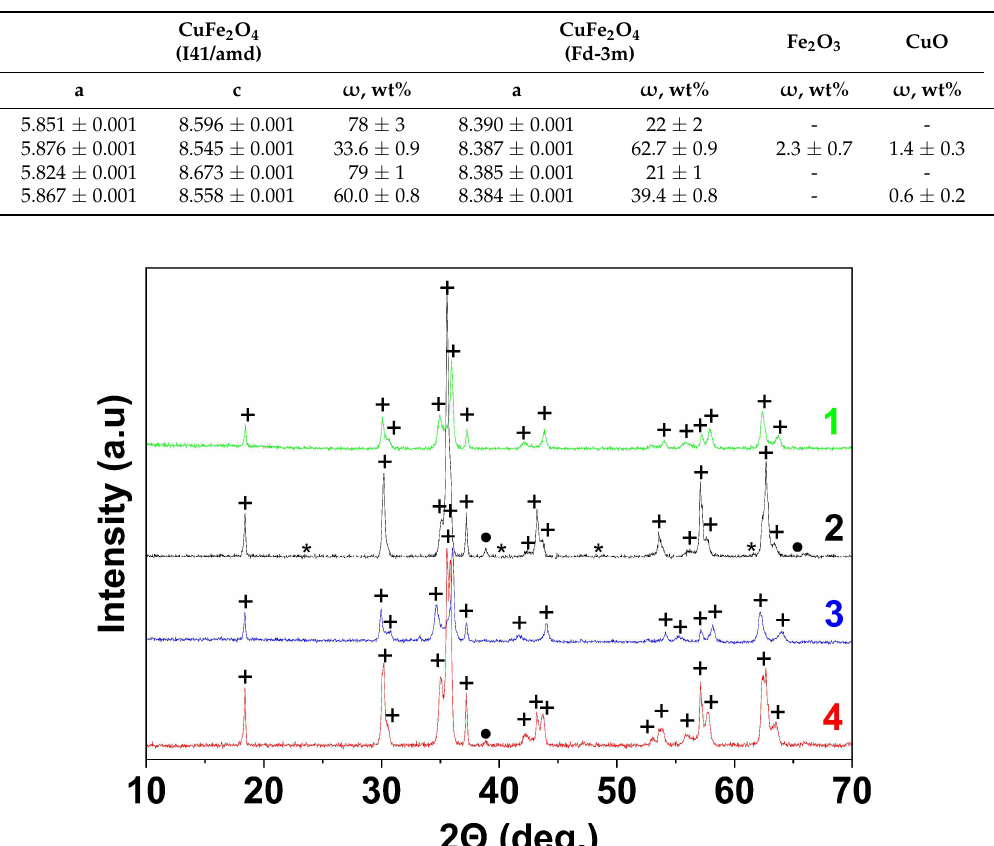
Figure 6. X-ray diffraction patterns of CuFe 2 O 4 powders annealed at 900 °C: 1—sample obtained without polysaccharides, 2—obtained with dextran-40, 3—obtained with dextran-70, 4—obtained with inulin, + CuFe 2 O 4 , * Fe 2 O 3 , • CuO.